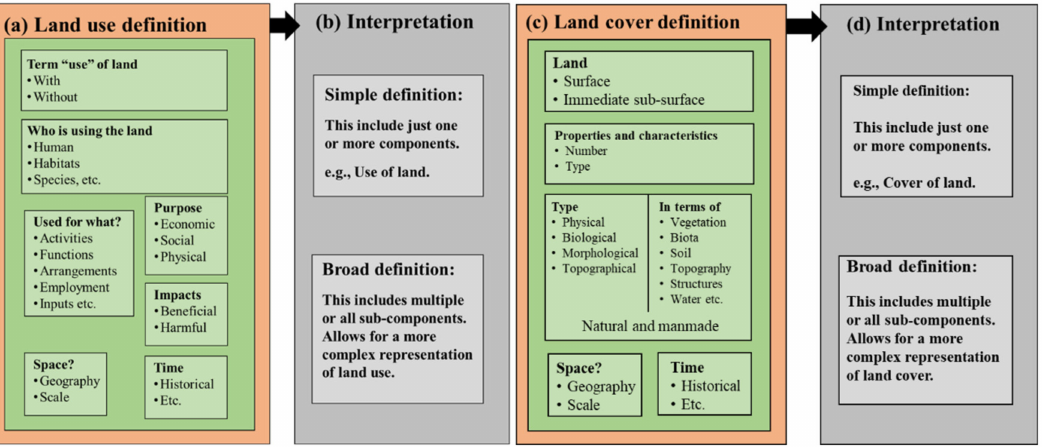
Figure 1. Showing simple and broad definitions of LULC developed and interpreted in this